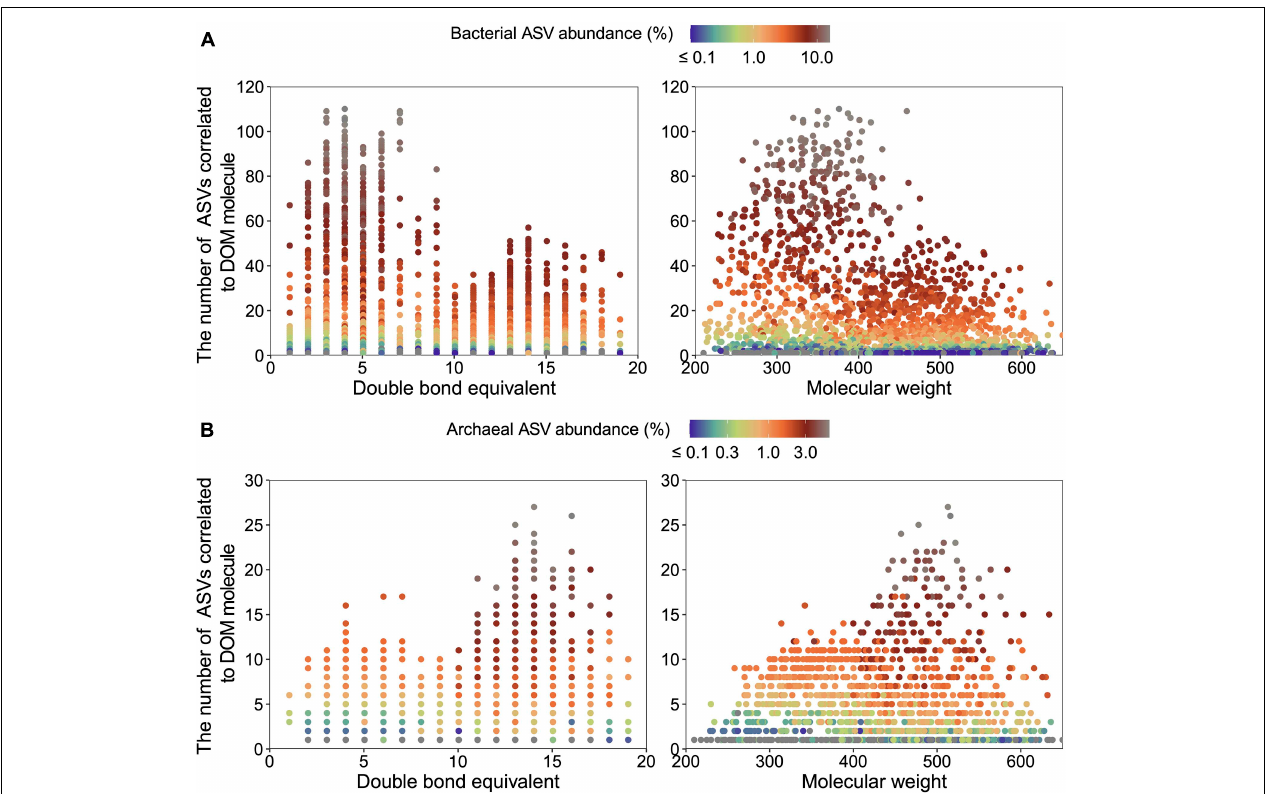
FIGURE 3 | Double bond equivalent (DBE) and molecular weight (MW) of DOM molecules significantly correlated (Pearson’s correlation with r ≥ 0.65, P < 0.01) to bacterial (397 amplicon sequence variants (ASVs) in total) (A) and archaeal (128 ASVs in total) compositions (B) . Note that an ASV may be counted more than once due to its correlations with